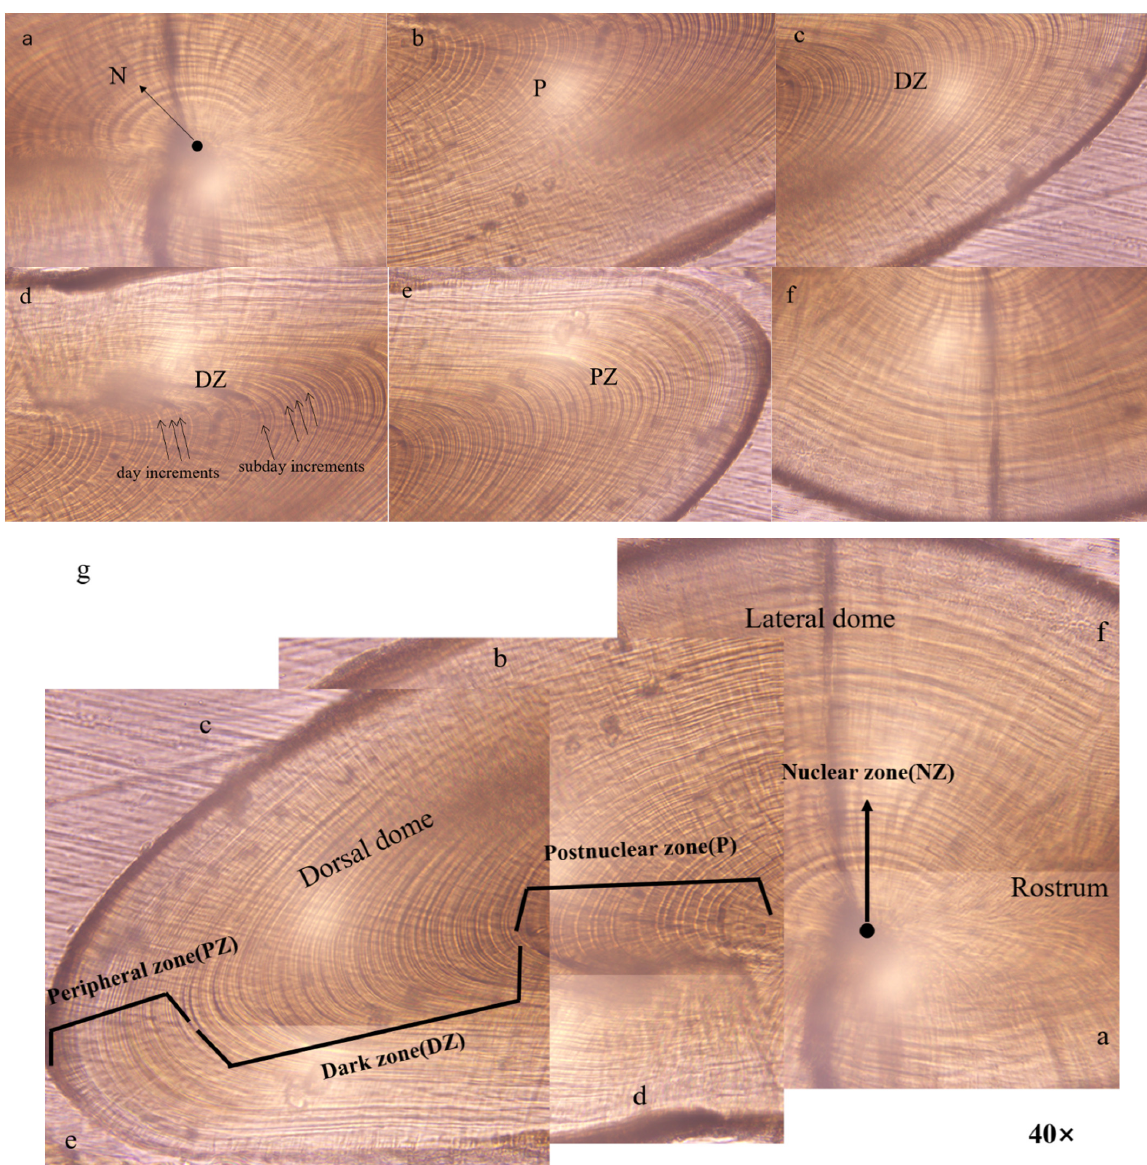
Figure 3. Statolith microstructure of B. magister shevtsovi (female with mantle length 110 mm, body weight 63 g, age 138 d). ( a ) showing the nuclear zone (N) within the zero ring; ( b ) showing the postnuclear zone (P); ( c , d ) showing the dark zone (DZ), and d showing the day increments and subday increments; ( e ) showing the peripheral zone (PZ); ( f ) ensure the integrity of the statolith microstructure; ( g ) showing three distinct growth zones with different incremental width.